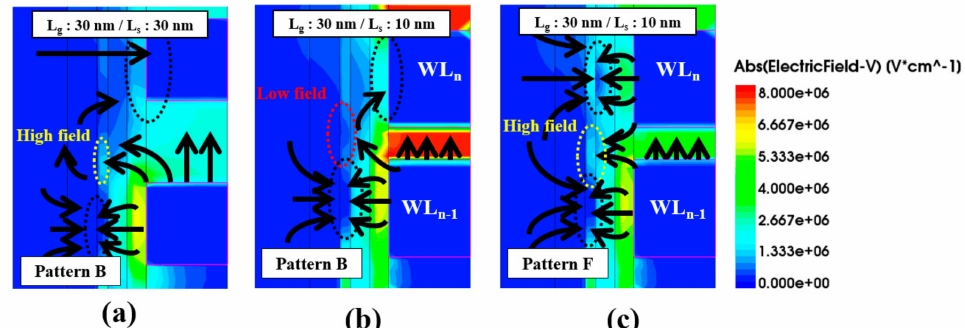
Figure 5. The E-field according to each pattern during the read operation. ( a ) Both gate and space length 30 nm, and pattern A, ( b ) gate length 30 nm space length 10 nm, and pattern B, ( c ) gate length 30 nm, space length 10 nm, and pattern F.